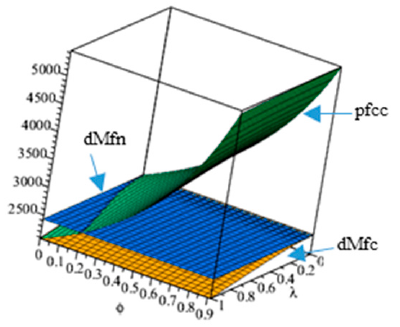
Figure 7. Effects of M’s fairness concerns on market demand.